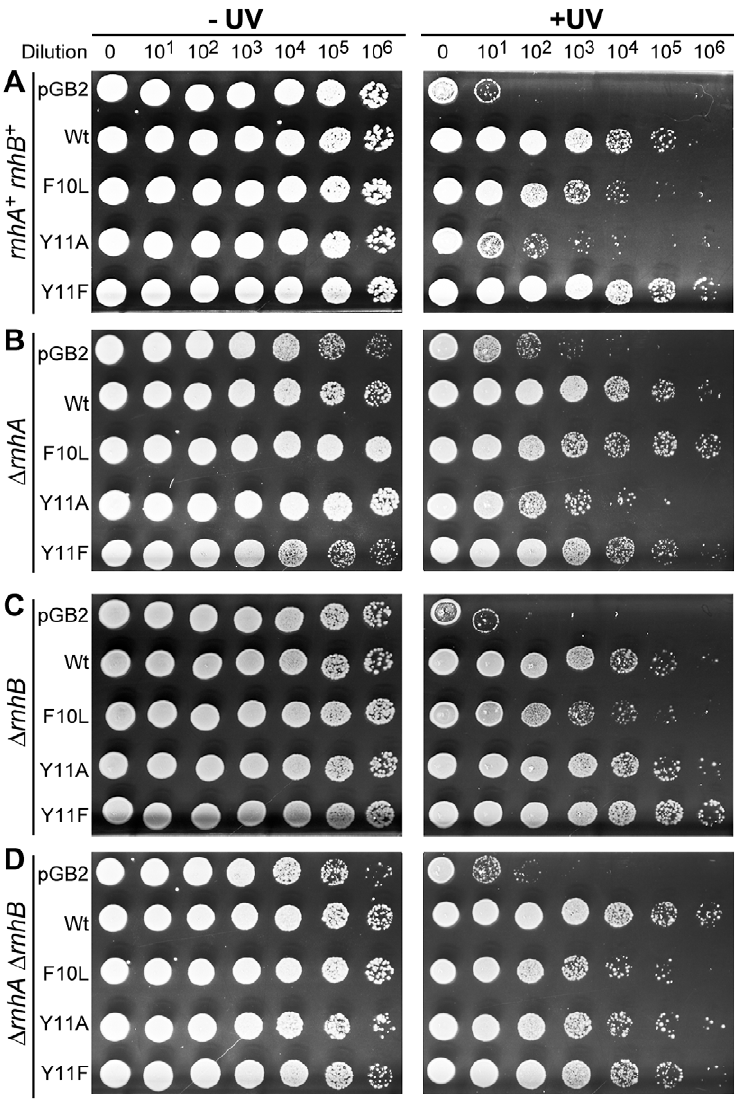
Figure 1. Effect of D rnhA and D rnhB on UV survival of recA730lexA (Def) D umuDC D dinB strains expressing pol V variants. 10 m l of 10- fold serial dilutions of overnight cultures were spotted onto the surface of rectangular LB agar plates and exposed to 40 J/m 2 254 nM UV-light (panels A and C) and 20 J/m 2 254 nM UV-light (panels B and D). Both unirradiated ( 2 ) and UV-irradiated ( + ) plates were incubated overnight at 37 u C. In each panel, UV survival is shown for the recA730 lexA (Def) D umuDC D dinB strains either harboring pGB2 vector, or expressing pol V variants. The main observation of these experiments is that the UV-resistance of cells expressing umuC _Y11A increase dramatically in strains lacking rnhB , whereas survival of cells equipped with wild-type pol V, umuC _F10L, or umuC _Y11F is largely unaffected by the status of rnhB . (Figure 2B). While there was a slight reduction in the level of UV- mutagenesis promoted by wild-type pol V in the D rnhB strain compared to the rnh + strain, we observed an , 9-fold increase in umuC _Y11A-dependent UV-induced mutagenesis in the D rnhB strain compared to the rnhB + strain (Figure 2B). Our observations therefore indicate that RNase HII plays a major role in preventing Y11A-dependent ribonucleotide-driven mutagenesis in E.coli . The rnhB gene encoding RNase HII is located in a multi-gene operon and is immediately upstream of the dnaE gene encoding the catalytic a -subunit of pol III [44]. To eliminate the possibility that the observed phenotypes of the D rnhB allele on Y11A- dependent mutagenesis might be non-specific, due to effects on expression of dnaE , we determined the levels of the a -subunit in isogenic dinB + / 2 rnhB + / 2 strains (Figure S3). In both the dinB + /